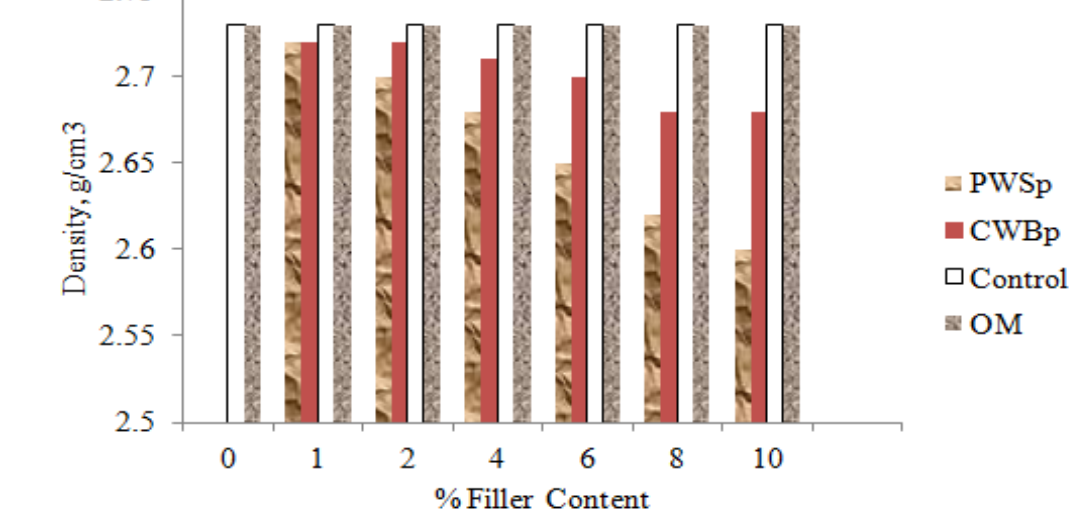
Figure 5: Density of the Al/Ps and Al/Cb composites Vs control sample and